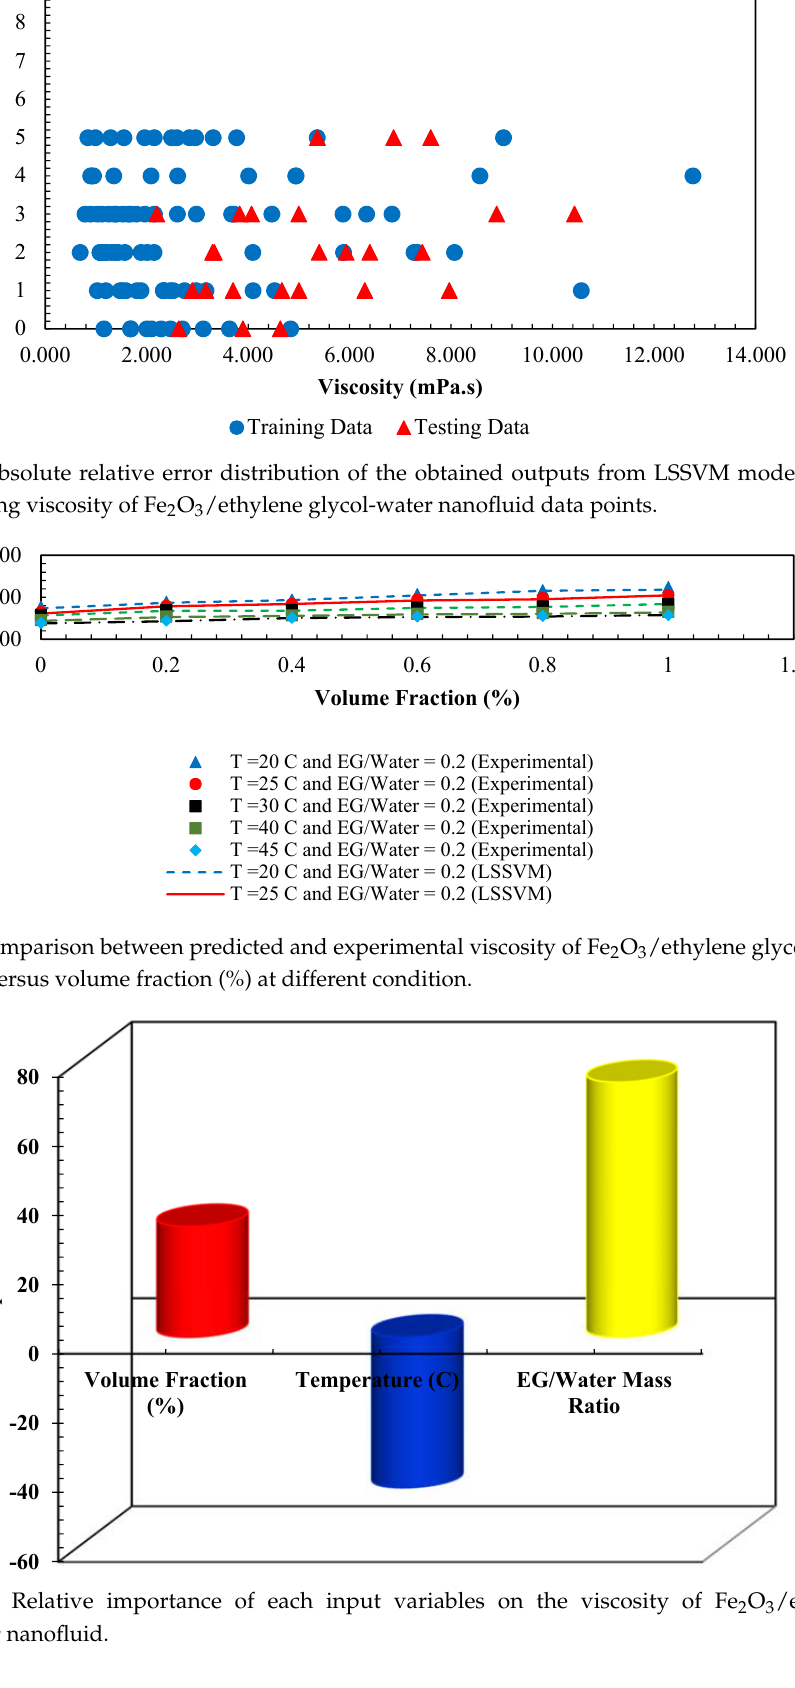
Figure 10. Relative importance of each input variables on the viscosity of (cid:1832)(cid:1857) (cid:2870) (cid:1841) (cid:2871) /ethylene glycol ‐ water nanofluid. 4.1.2. PSO ‐ ANN Model for Viscosity Performance of the PSO ‐ ANN model in predicting viscosity is presented in this section and has been compared with the GA ‐ LSSVM model. In Figure 11, a regression plot between obtained data using PSO ‐ ANN model and actual data is represented. As can be seen, there are not sufficient data are around the diagonal line (Y = X) which demonstrates that the model is not very accurate. Similar to the previous section, the statistical criteria are used to assess the accuracy of the model. The values of mean squared errors (MSE), average absolute relative deviations (AARD), and determination coefficients (R 2 ) are represented in Table 4. The superior performance of the LSSVM model in